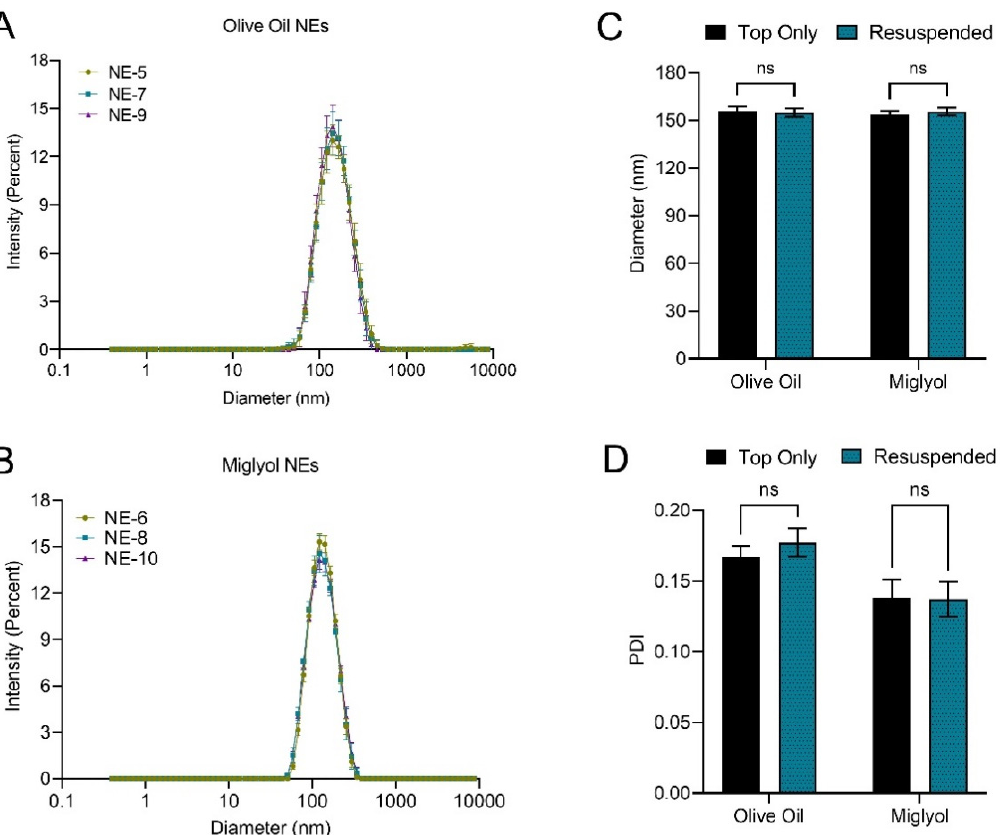
Figure 7. The impact of hydrocarbon oil on nanoemulsion size distribution. ( A , B ) Size distribution by intensity of nanoemulsions produced with ( A ) olive oil and ( B ) miglyol. ( C , D ) Nanoemulsion stability upon storage at 4 °C. Nanoemulsions were stored undisturbed for 20 days, after which ( C ) diameter and ( D ) PDI were measured before (top only) and after (resuspended) nanoemulsion was thoroughly mixed. ns, no significance.